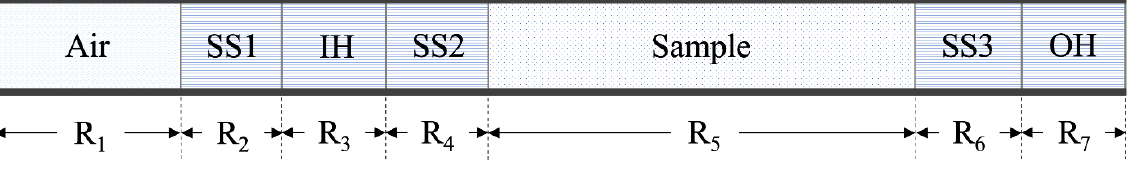
Figure 1. TPCell Schematic of 1D axisymmetric model. Air—air inside the hollow steel